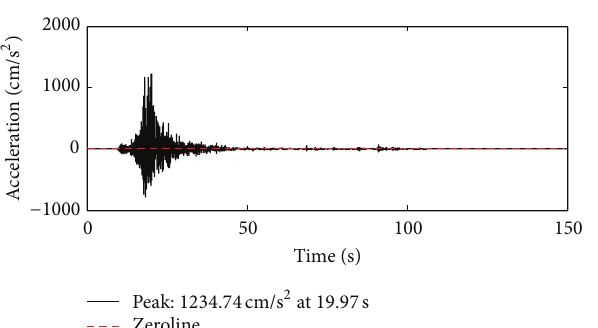
Figure 7: Acceleration time history (NZROLC.raw, UP, ratl = 1.45, ratr =